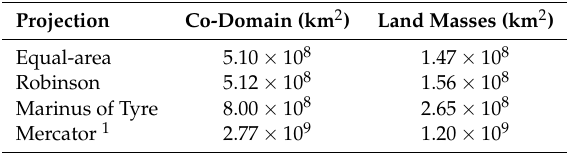
Table 1. Total areas of co-domain and land masses with different map